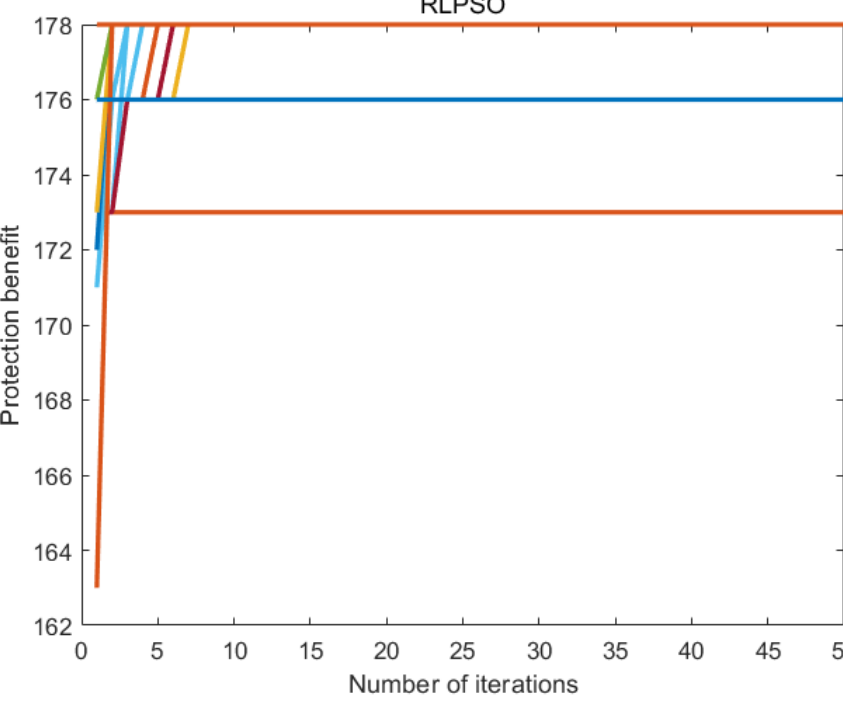
Figure 12. Population size is 100, and the RLPSO algorithm is run 100